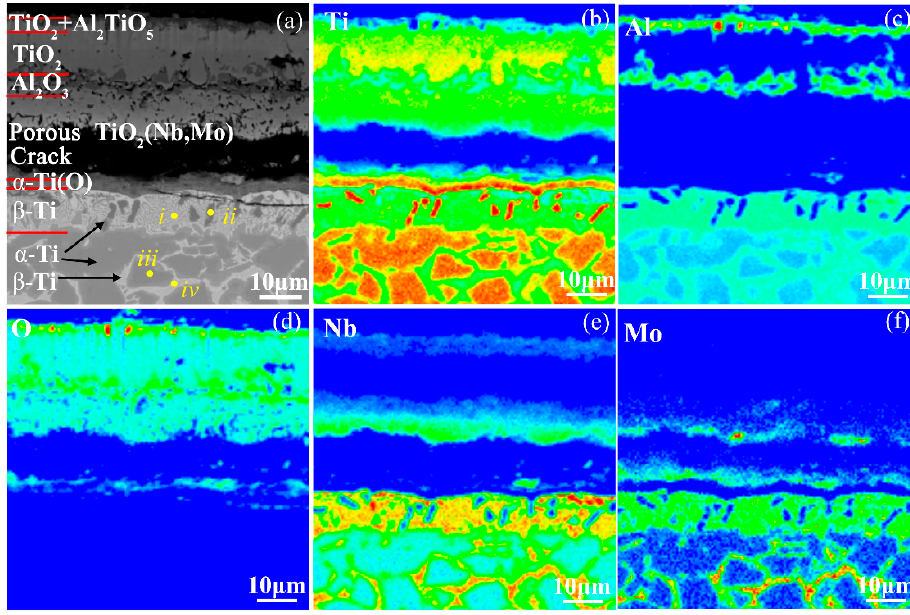
Figure 12. ( a ) Cross-sectional morphology and ( b – f ) the corresponding elemental distribution maps of the oxide scale formed during heating the Ti-24Al-15Nb-1.5Mo alloy to the end of Stage IV. Table 2. Chemical compositions of the microstructures in the Ti-24Al-15Nb-1.5Mo alloy examined by an electron probe microanalyzer (EPMA) after heating the alloy to the end of Stage IV. Compositions Microstructures in Figure 12a